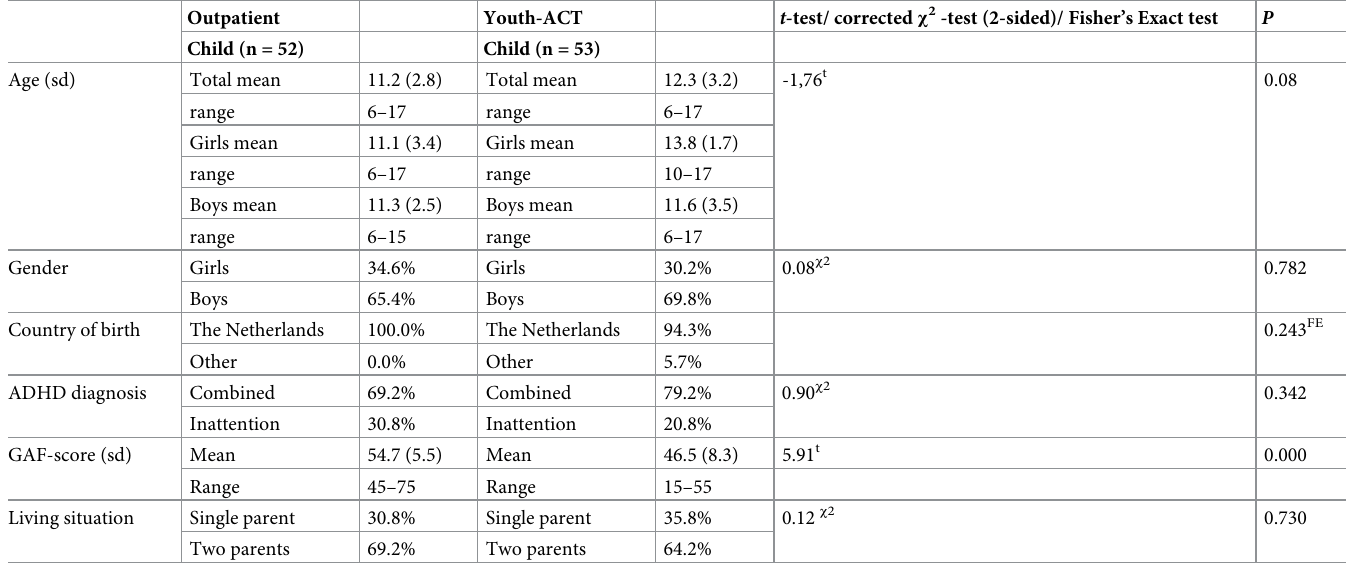
Table 1. Sample characteristics of the child or adolescent who received